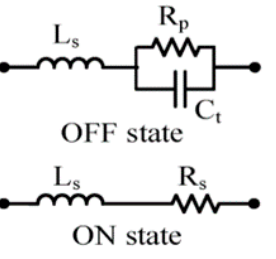
Figure 4. RLC model of the switches in the ON and OFF configurations.